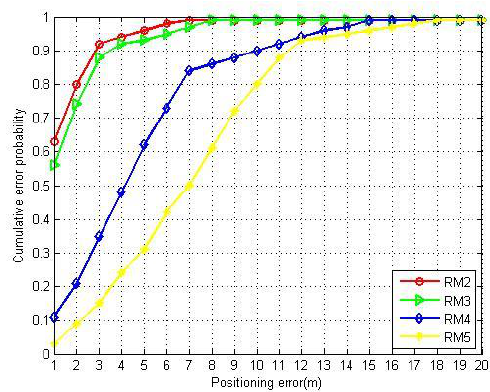
Figure 6. The positioning errors under different proportions of labeled fingerprints.